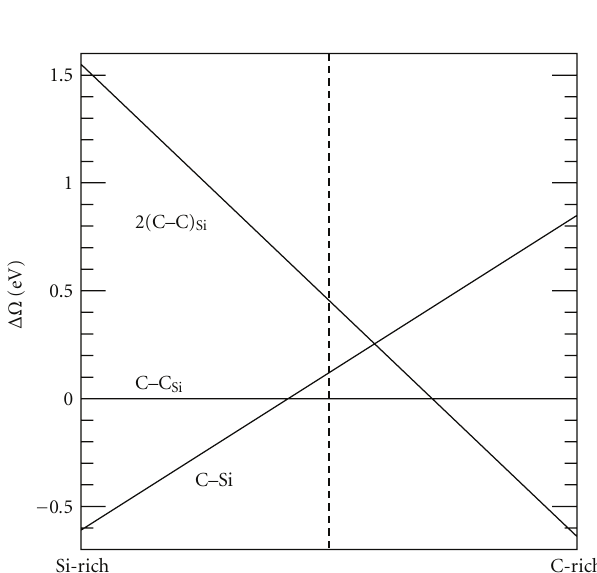
Figure 3: Relative formation energies ( ΔΩ ) of the most stable C defects in Si-coated [100] SiC NW. The vertical dashed line corresponds to the stoichiometric